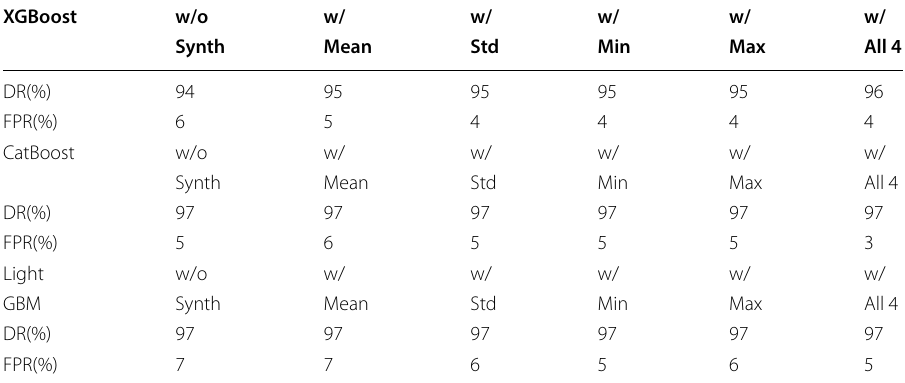
Table 17 From [31], “Performance comparison without or with new feature(s) (average of 100 random customers), where revised theft cases are used